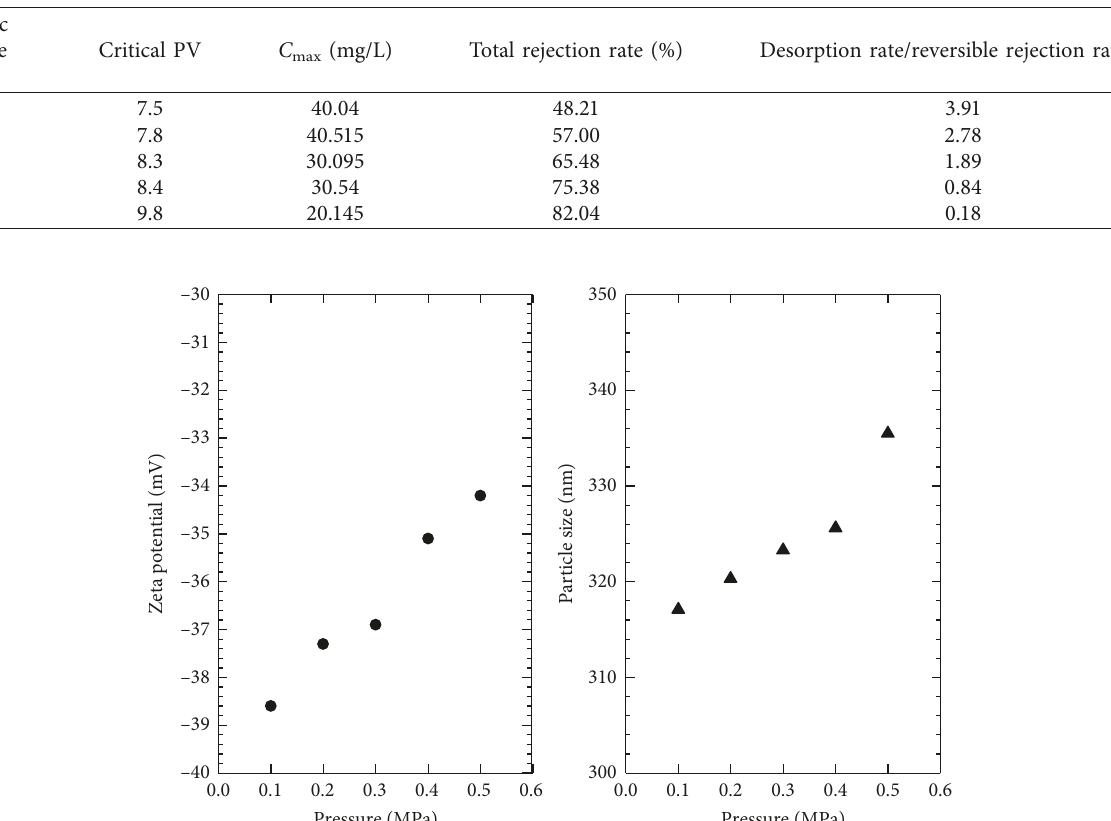
Figure 4: (a) Zeta potential of nZnO suspension and (b) particle size of nZnO particles under different osmotic pressures.